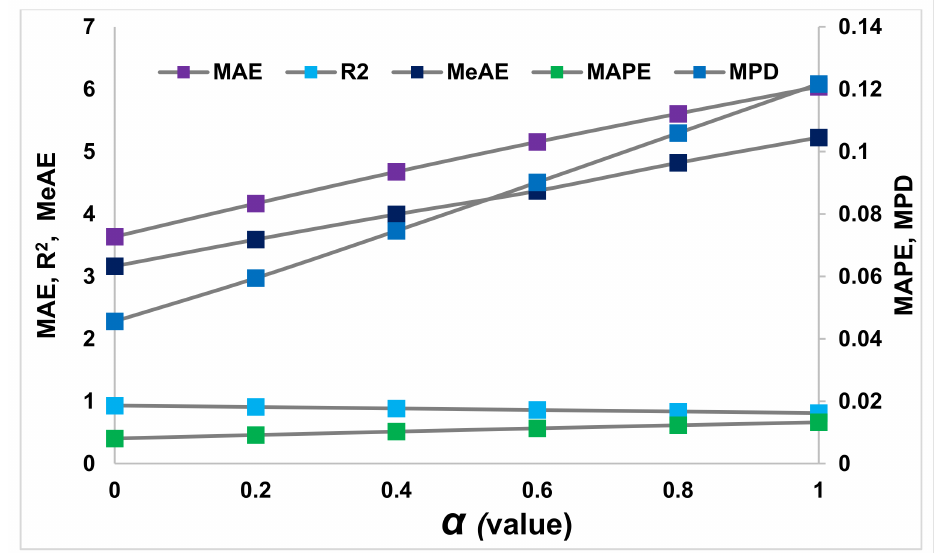
Figure 8. Ridge regressor performance metrics change linearly with α values in the tested dataset (R 2 is shown as R2 in the graph